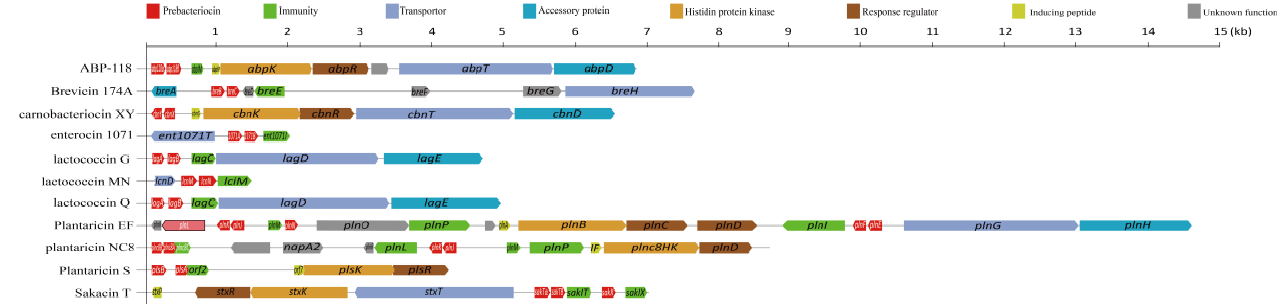
Figure 4. Organization of biosynthetic gene clusters of class IIb bacteriocins of